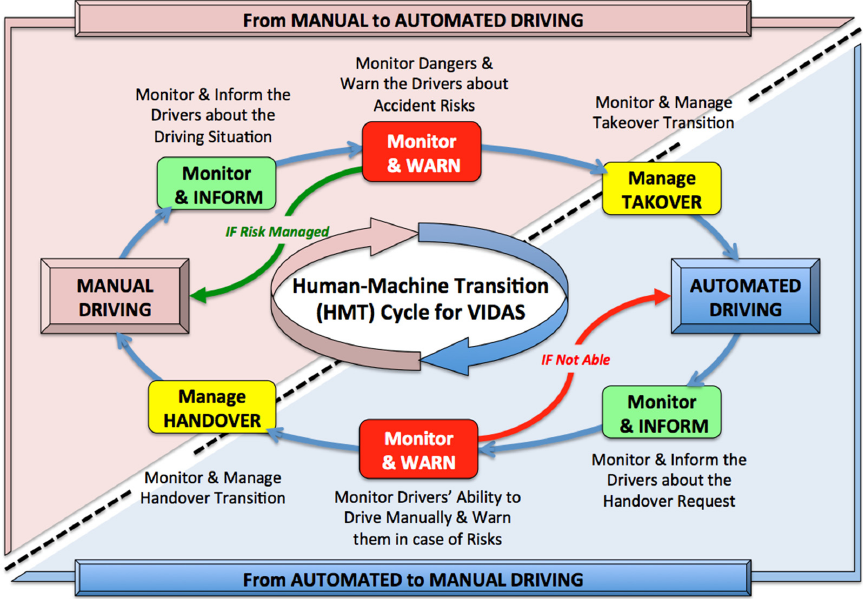
Figure 1. The Human-Machine Transition (HMT) framework [10].